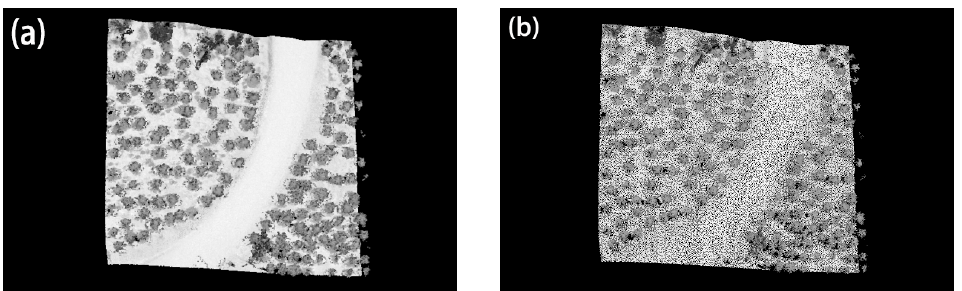
Figure 10. The downsampling results of the second laser point cloud datasets in region B : ( a ) raw data points; ( b ) downsampled points.